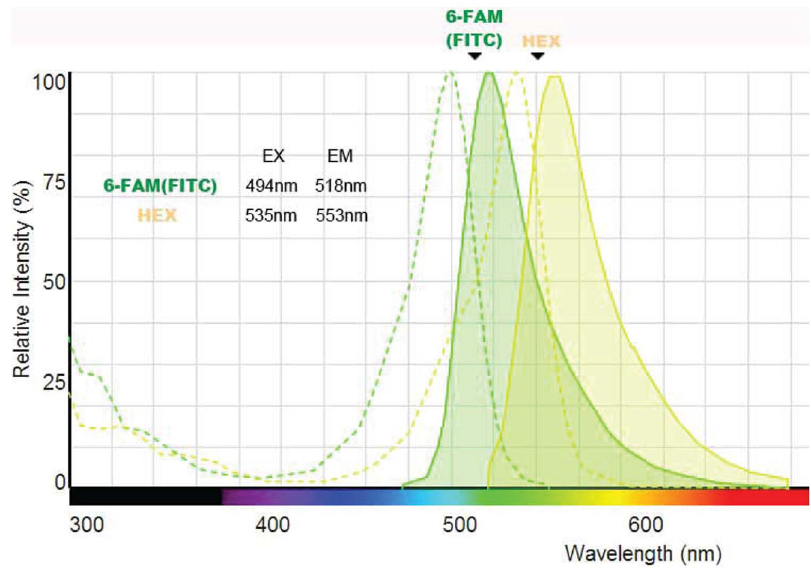
Figure 12. Fluorescence spectra of 6-FAM(FITC) and HEX.